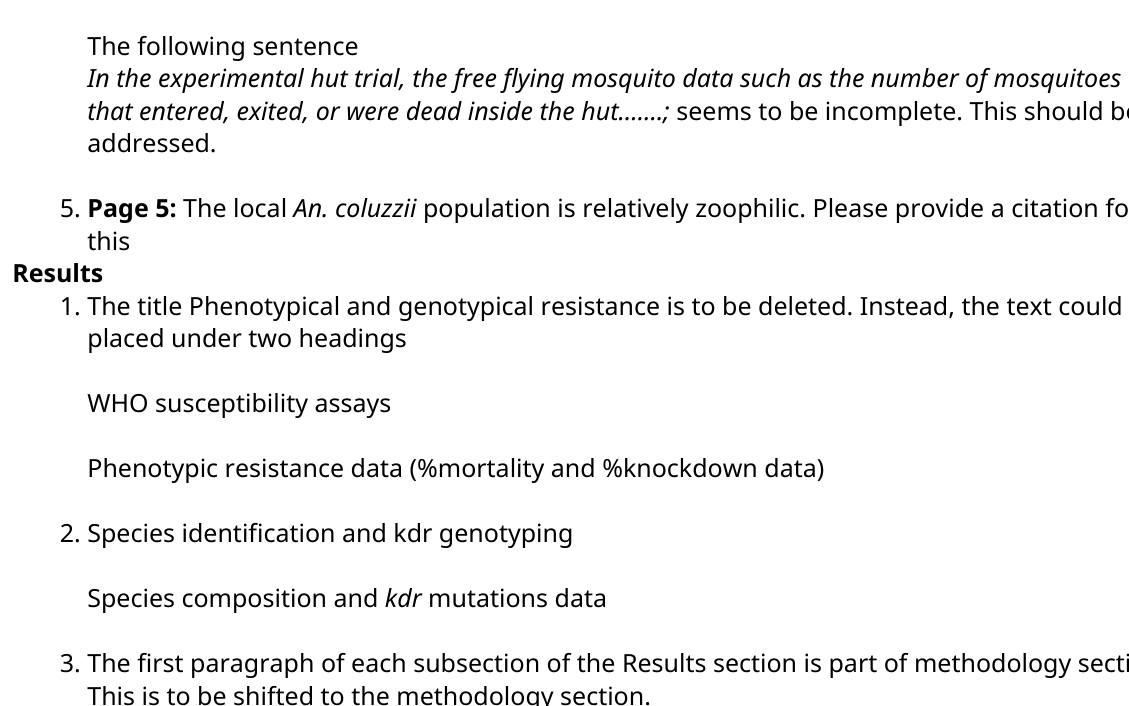
Table 4: HPLC analysis or Insecticide application quality ○ Table 5: WHO susceptibility assay ○ Table 6: Species identification and kdr genotyping